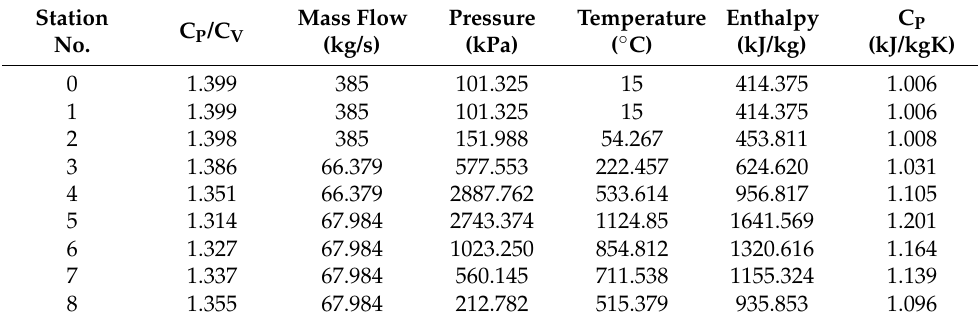
Table 2. Performance characteristics at each station for jet fuel (kerosene) at altitude = 0 m. Station